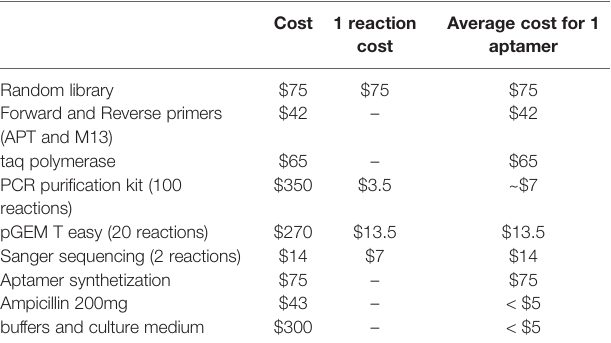
TABLE 2 | Average cost for aptamer selection and identi fi cation using the methodology proposed here totaling